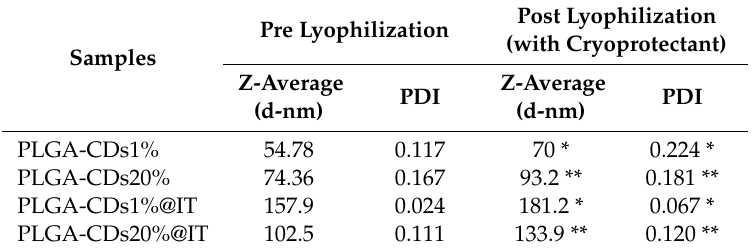
Table 1. Summary size and PDI of PLGA-CDs NPs and PLGA-CDs@IT NPs pre- and post-lyophilization.